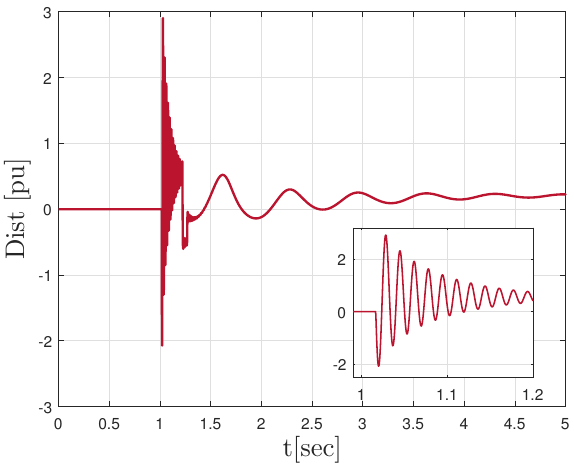
Figure 2. Disturbance resulting from a stable power